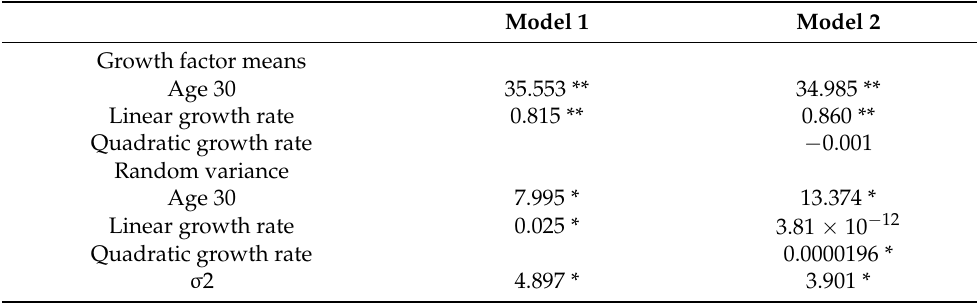
Table 2. Linear and quadratic models of change in CC-Bd as a function of age using unconditional growth models ( n =